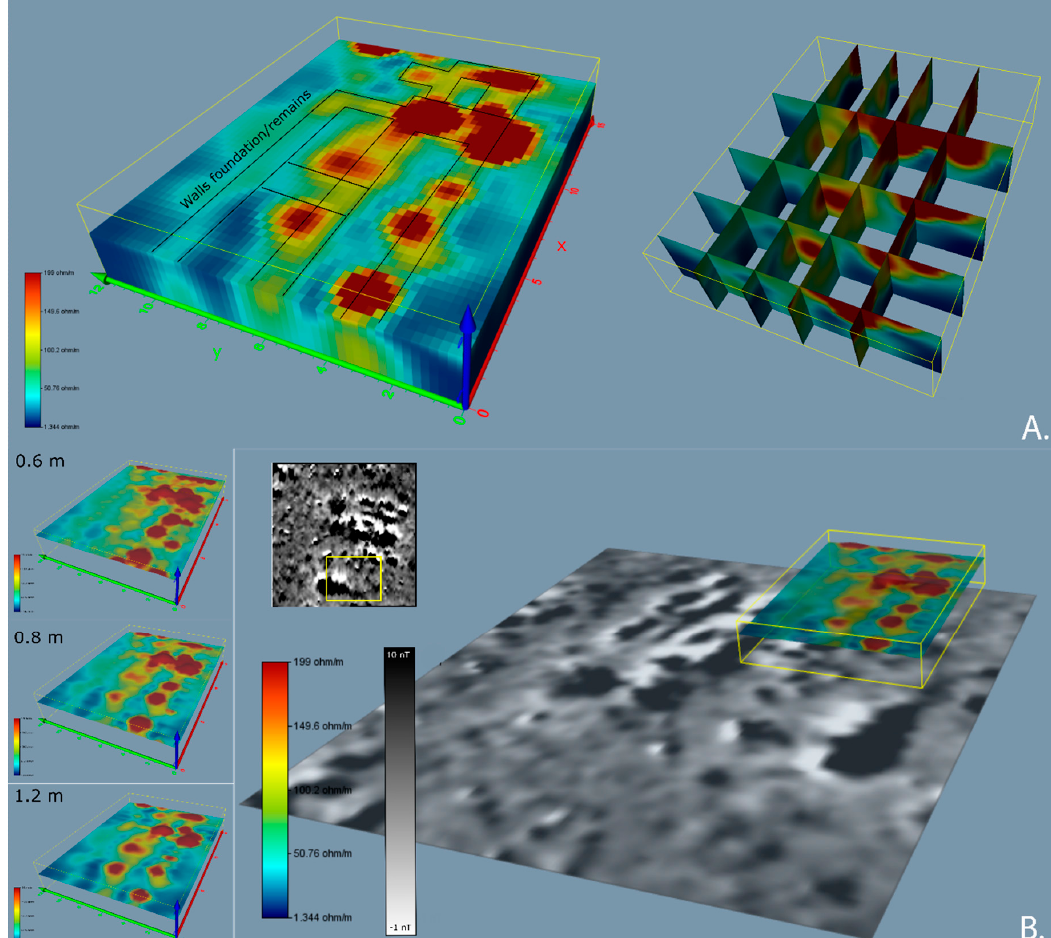
Figure 10. Electrical resistivity tomography (ERT) gridded survey: ( A ) Resistivity model (left), YZ plane (sagittal) and XZ plane (coronal) slices; ( B ) depth slices (left) and depth slice overlaying magnetic map (right).